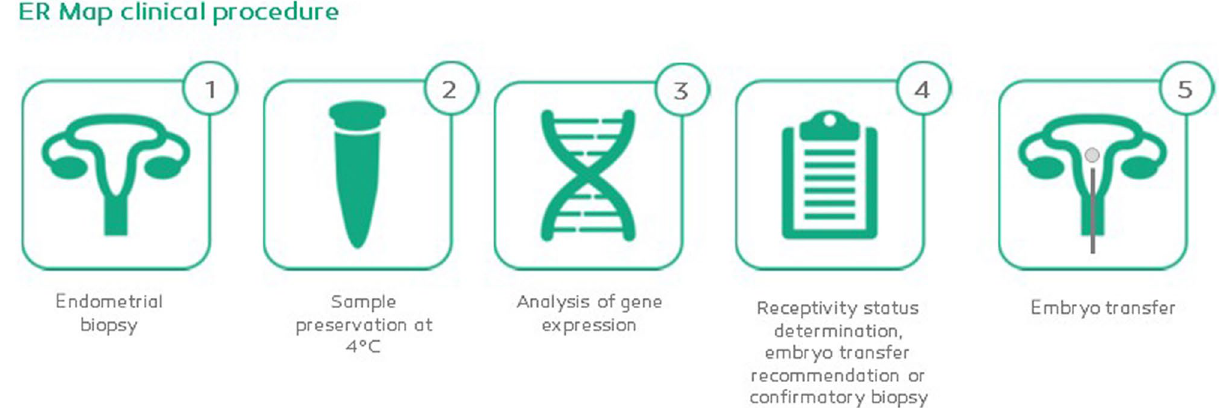
Figure 3. ER Map clinical procedure diagram. Modified from “[pking4th, alexutemov, greyjj]